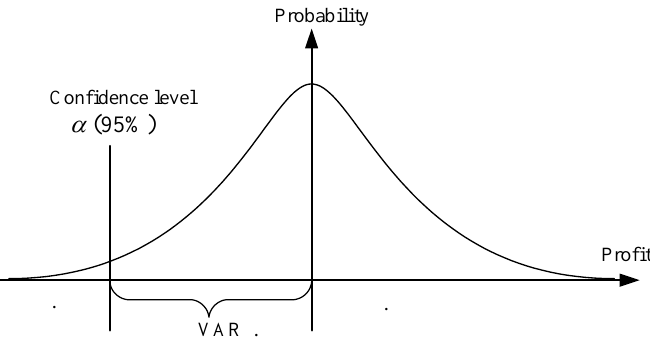
Figure 1. Diagram of the Value at Risk (VAR) calculation.